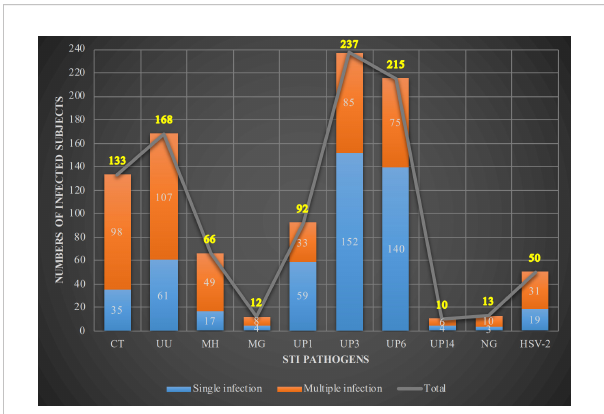
FIGURE 3 Types and proportions of the detected STI pathogens. Numbers of subjects with single infection, multiple infection, and total infection with detected STI pathogens shown. STI, sexually transmitted infection; CT, Chlamydia trachomatis ; UU, Ureaplasma urealyticum ; MH, Mycoplasma hominis ; MG, Mycoplasma genitalium ; UP, Ureaplasma parvum ; NG, Neisseria gonorrhoeae ; HSV-2, herpes simplex virus type